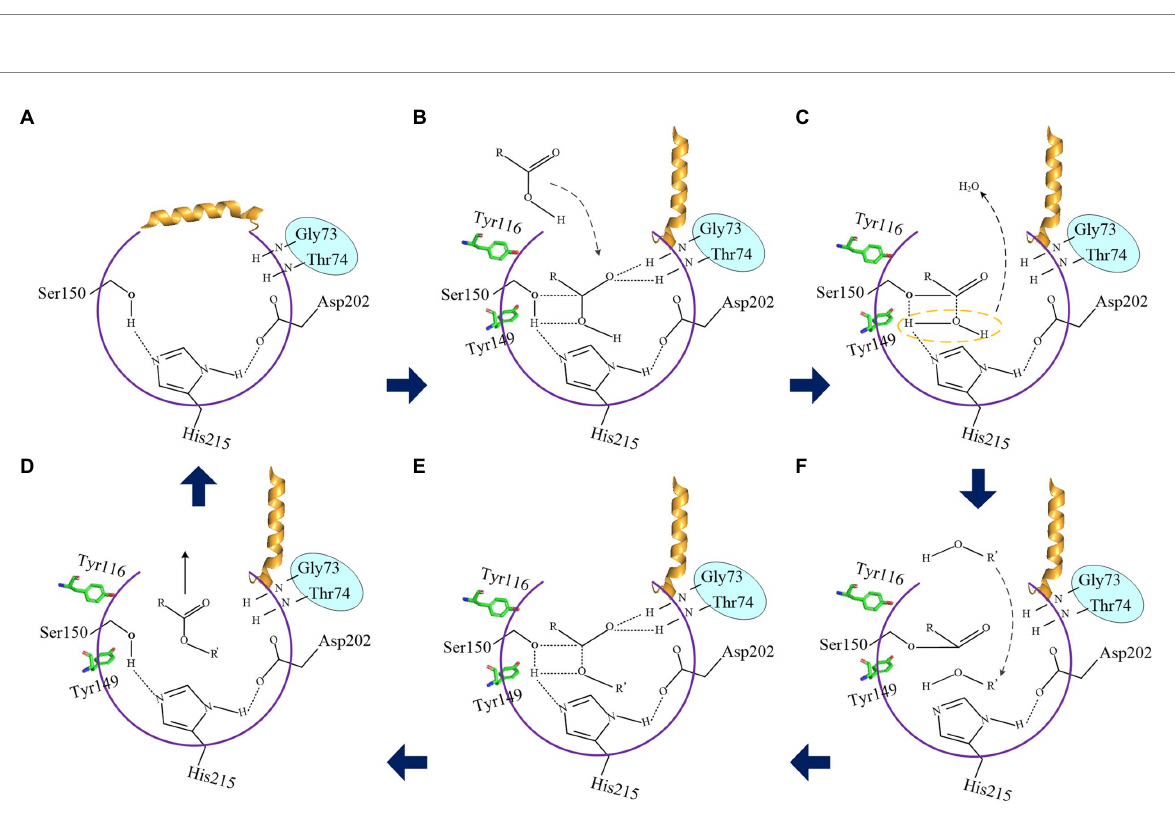
FIGURE 10 The proposed catalytic mechanism of LIP05. (A) Closed state of the lid domain of LIP05. (B) Lid domain of LIP05 opened, and the substrate acid entered into the catalytic active center. (C) Tetrahedral transition state 1. (D) Substrate alcohol entered into the catalytic active center. (E) Tetrahedral transition state 2. (F) The esterification reaction was